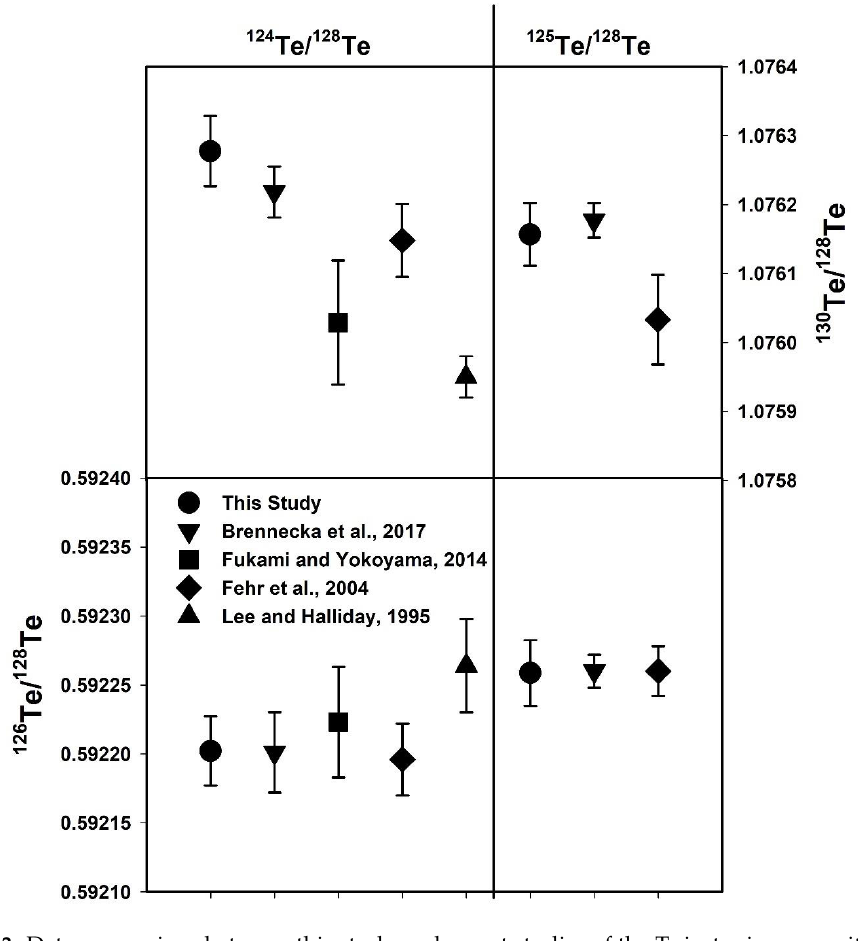
Figure 3. Data comparison between this study and recent studies of the Te isotopic composition for 126 Te/ 128 Te and 130 Te/ 128 Te ratios. The two different internal normalizations are shown on the top for comparison. Molecules 2020 , 25 , x FOR PEER REVIEW 7 of 17